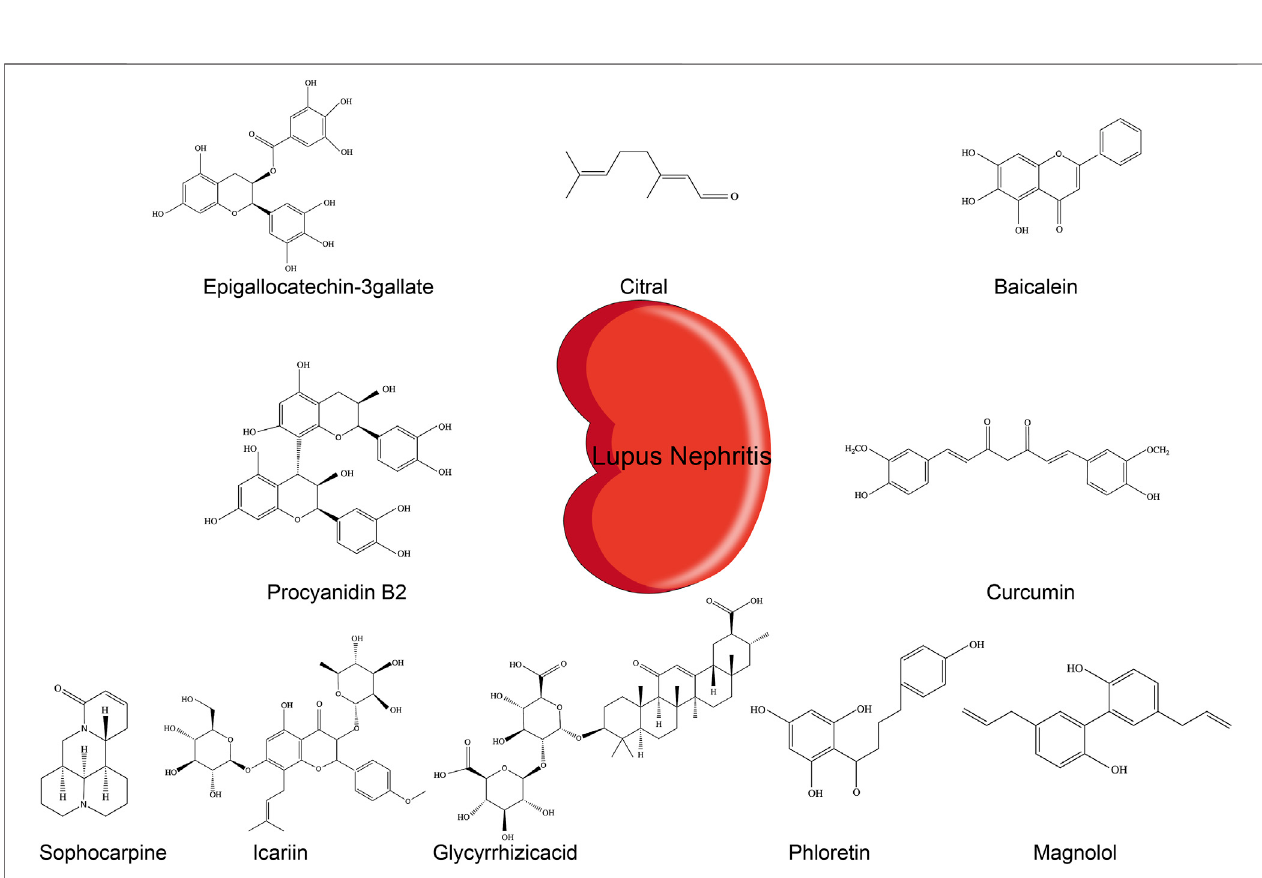
FIGURE 2 | Chemical structures of different phytochemicals blocking NLRP3 in fl ammasome pathways in LN.